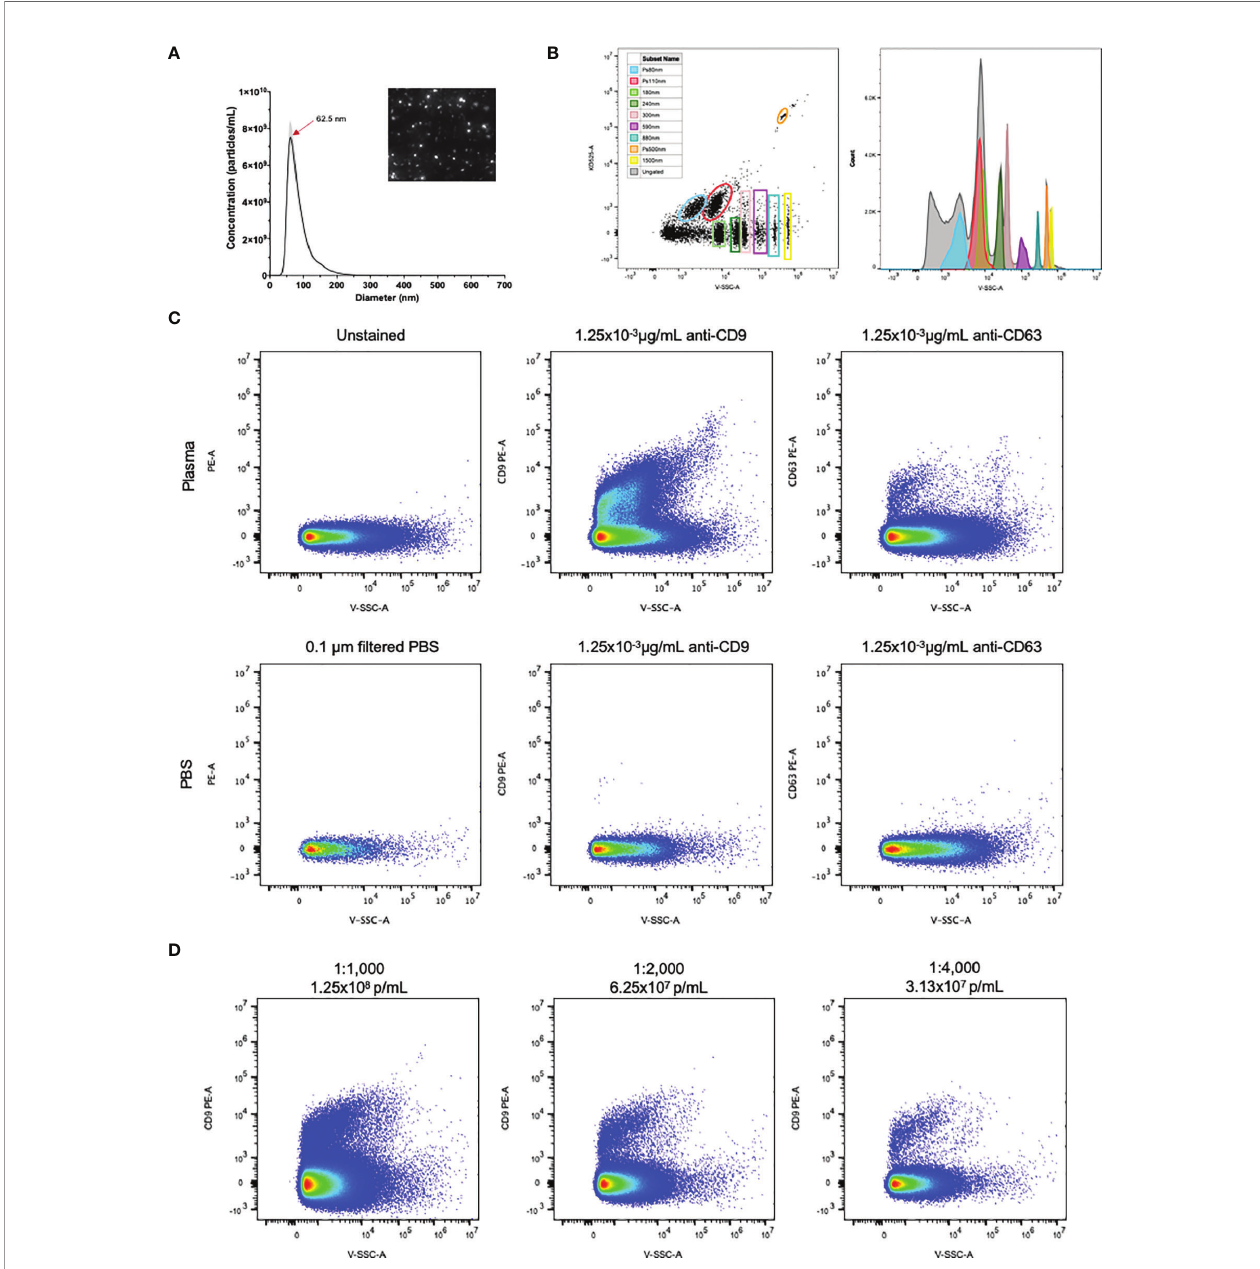
FIGURE 1 | EVs in plasma are detectable by fl ow cytometry. (A) NTA particle size distribution with representative video screenshot (inset) of control human plasma. (B) Detection of size calibrated beads (Apogee) using violet side scatter (V-SSC-H) as the threshold parameter. Three of the bead populations we fl uorescently labelled with the KO525 fl uorophore and separated based on size (along the X axis) and fl uorescence (along the Y axis). Histogram (right) reveals separation of all size beads based on V-SSC. (C) Positive staining of EVs labelled with antibodies against the EV markers CD9 and CD63, using antibodies diluted in 0.1µm fi ltered PBS as negative controls. (D) Plasma dilution series showing separation of PE positivity from background. Final antibody concentration was 0.019, 9.38x10 -3 and 4.69x10 -3 µg/mL for 1:1000, 1:2000 and 1:4000